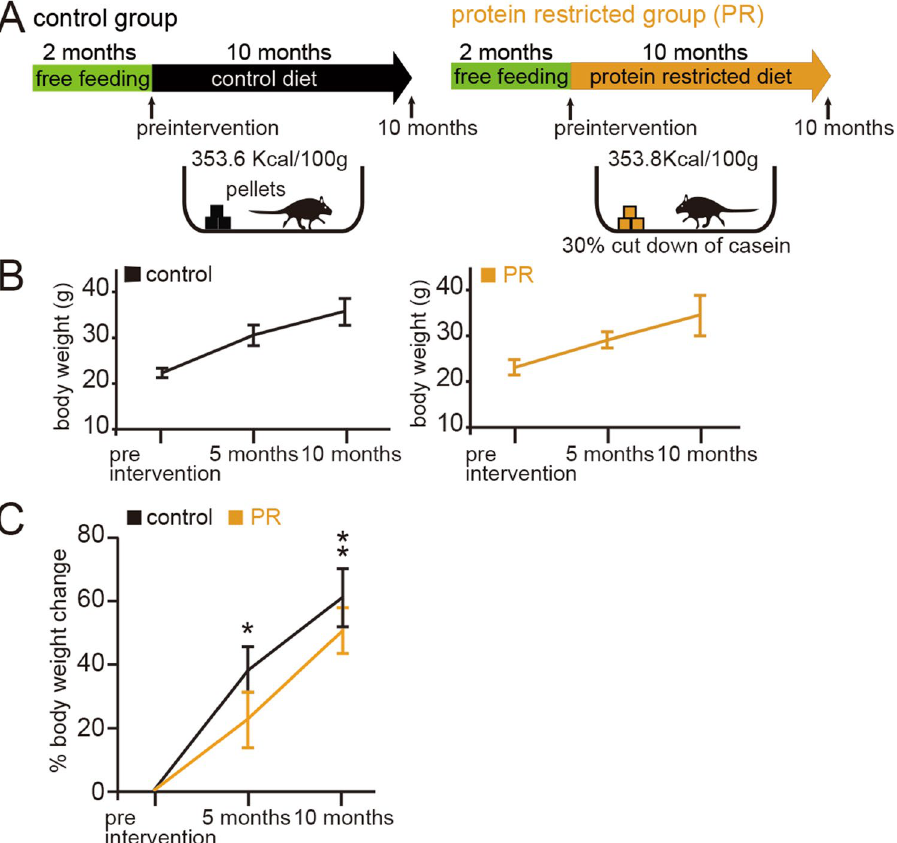
Figure 1. Effects of protein restriction on body weight. ( A ) Method of protein restriction (PR). Mice at 2 months old (preintervention) were divided into two groups: controls, fed a control diet for the following 10 months (353.6 kcal/100 g); and PR, fed a protein-restricted diet for the following 10 months (353.8 kcal/100 g). All mice were exposed to odors for c-fos experiments before fixation. ( B ) Body weights of control (left) and PR mice (right) at preintervention (2-month-old mice), 5 months (7-month-old mice), and 10 months (12-month-old mice) in each group (eight mice in each group). Data are shown as mean ± SD. ( C ) Percent body weight differences at preintervention, 5 months, and 10 months (eight mice in each group). At 5 and 10 months, a significant reduction in percent body weight change was observed in PR mice compared with control mice (*P < 0.05, **P < 0.01, Mann–Whitney test). Data are shown as mean ±